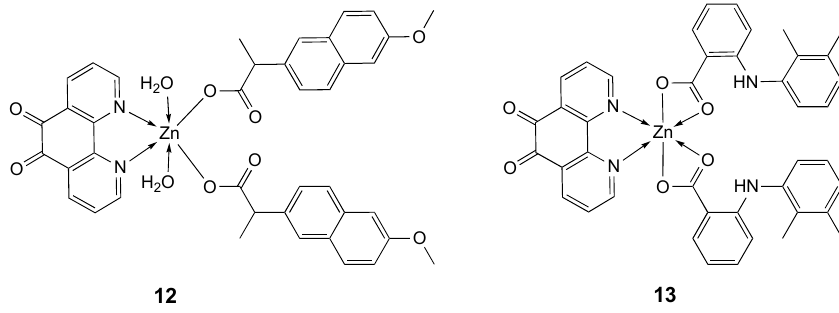
Figure 8. Structure of the zinc-NSAID complexes 12 and 13 with naproxen and mefenamic acid, respectively.